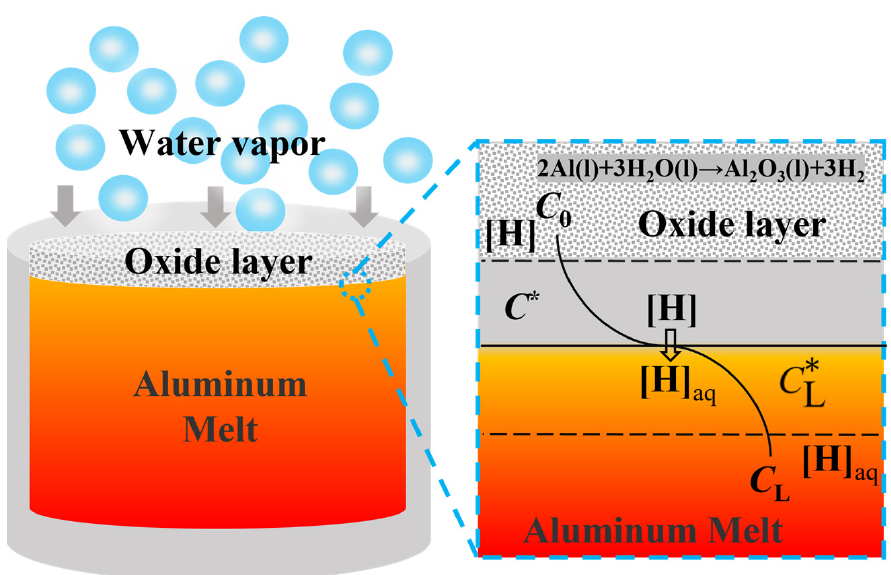
Figure 8. Schematic diagram of hydrogen absorption process of aluminum melt.